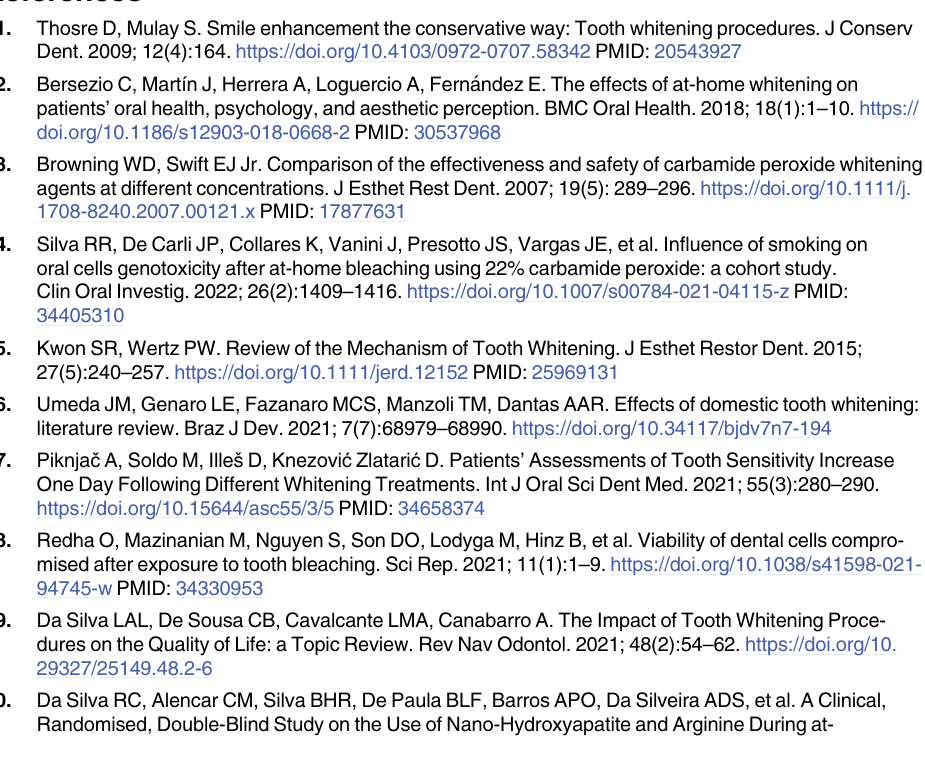
S2 Protocol. Copy of the protocol of the complete and detailed study project approved by the ethics committee translated into